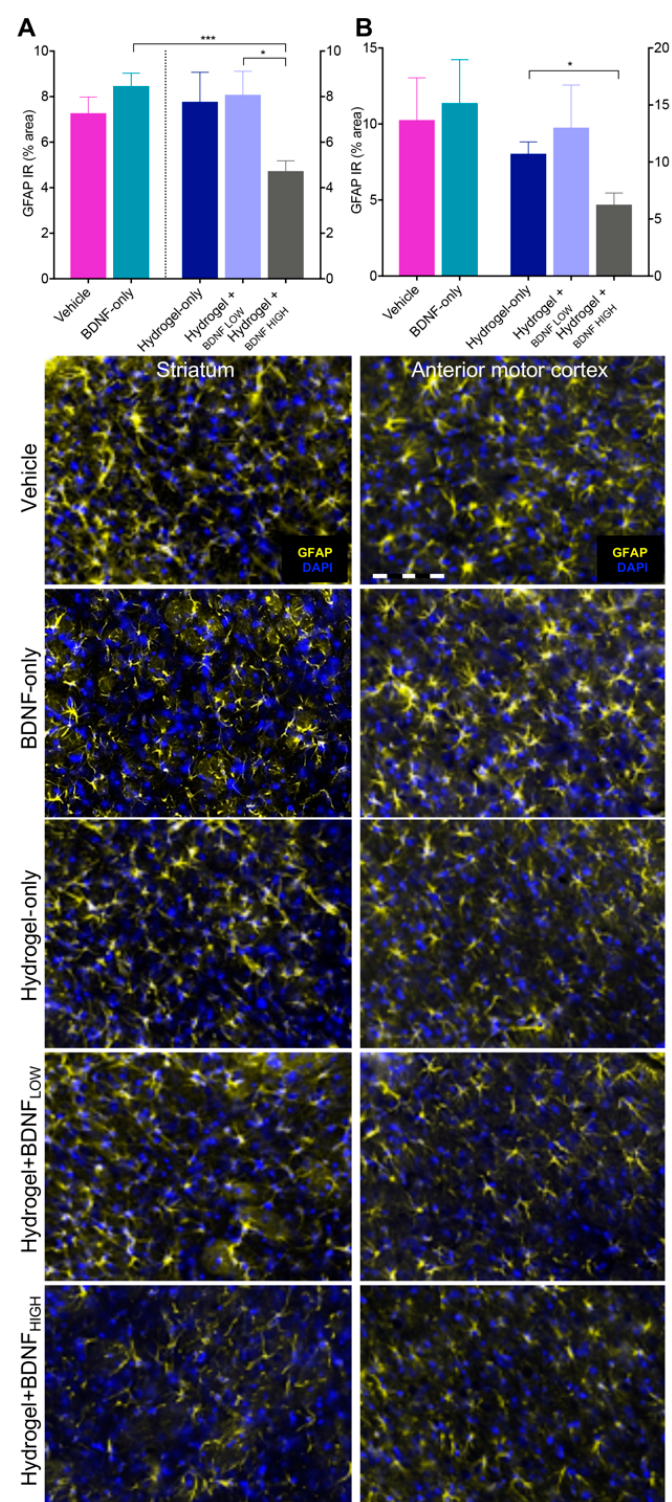
Figure 6. Effects of BDNF and delivery vehicle on astrogliosis following dMCAo. Hydrogel + BDNF HIGH treatment reduces GFAP IR in the ipsilateral ( A ) corpus striatum and ( B ) anterior motor cortex. Representative photomicrographs of GFAP (Cy5, mapped to yellow) and DAPI nuclear stain (blue) at 20 × magnification from each treatment group and ROI are shown below. Vehicle ( n = 5), BDNF-only ( n = 5), hydrogel-only ( n = 5), hydrogel + BDNF LOW ( n = 5), and hydrogel + BDNF HIGH ( n = 5). Scale bar = 20 µ m. IR = immunoreactivity. Error bars indicate the mean ± SEM; * p < 0.05, *** p < 0.001.